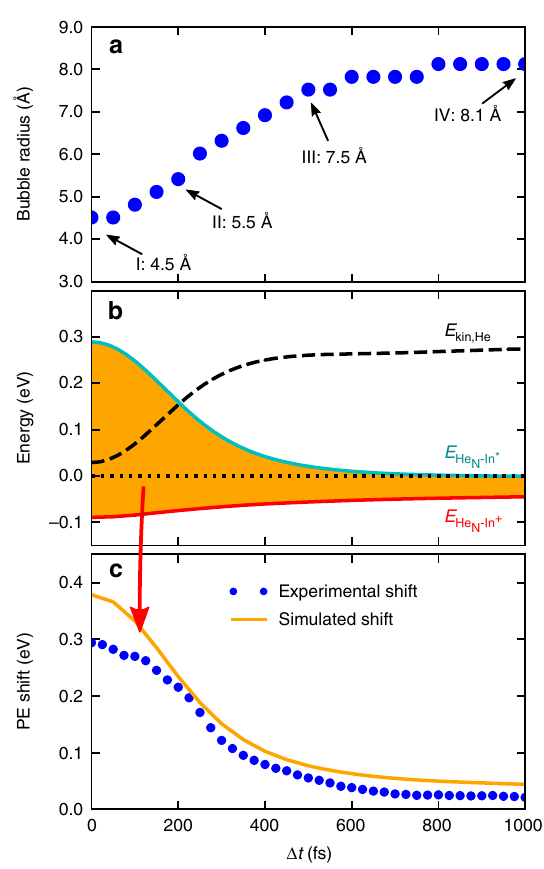
Fig. 4 Photoexcitation (PE) dynamics of the In – He 4000 system simulated with TDDFT. a Bubble radius as a function of time delay Δ t , determined as the position of the corresponding He distribution at which the density has dropped to 50% of the bulk value. Times for which the calculated He density is shown in Fig. 1b are indicated. b Interaction energy E of the He N (cid:1) In (cid:3) 5 s 2 6 s excited state (cyan curve) and interaction energy E of the 5 s 2 He N (cid:1) In þ ionic state (red curve). Additionally, the kinetic energy of the He atoms, E kin, He , is plotted as dashed line. c Simulated PE peak shift induced by the He − E environment (orange line), obtained as E (indicated by He N (cid:1) In (cid:3) He N (cid:1) In þ the shaded area in b ), which is also shown in Fig. 2a. For comparison to the measured shift of the PE peak position over time, the recorded electron spectra at all time delays (c.f., Fig. 2b) are fi tted with Gaussian functions and the line positions are indicated here by blue